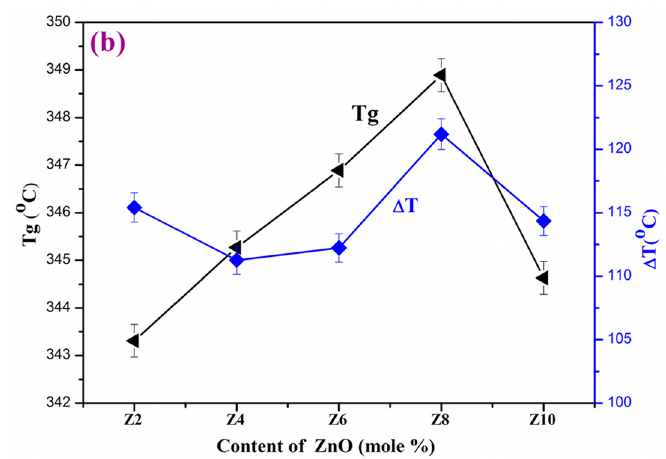
Figure 2. ( a ) TG-DTA traces of Z2, Z4, Z6, Z8 and Z10 bioglasses and ( b ) variation of thermal stability and glass transition (Tg) as a function of ZnO (mol%). Table 3. Thermal properties of ZnO doped phosphate bioactive glasses.